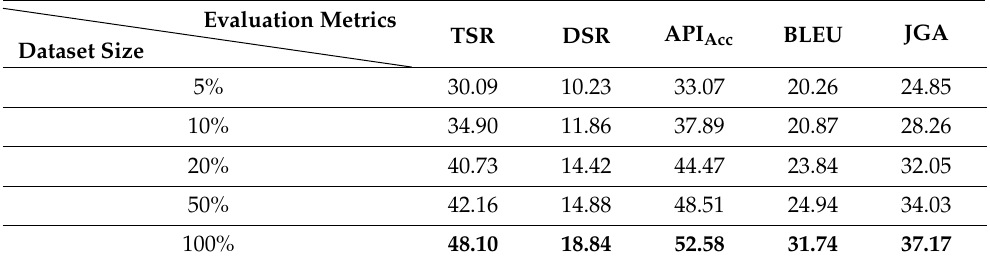
Table 4. Few-shot learning results of cross-lingual model deployed with MTL approach on the Arabic-TOD dataset using training dataset of different sizes. Bold numbers indicate the best result according to the column’s metric value.